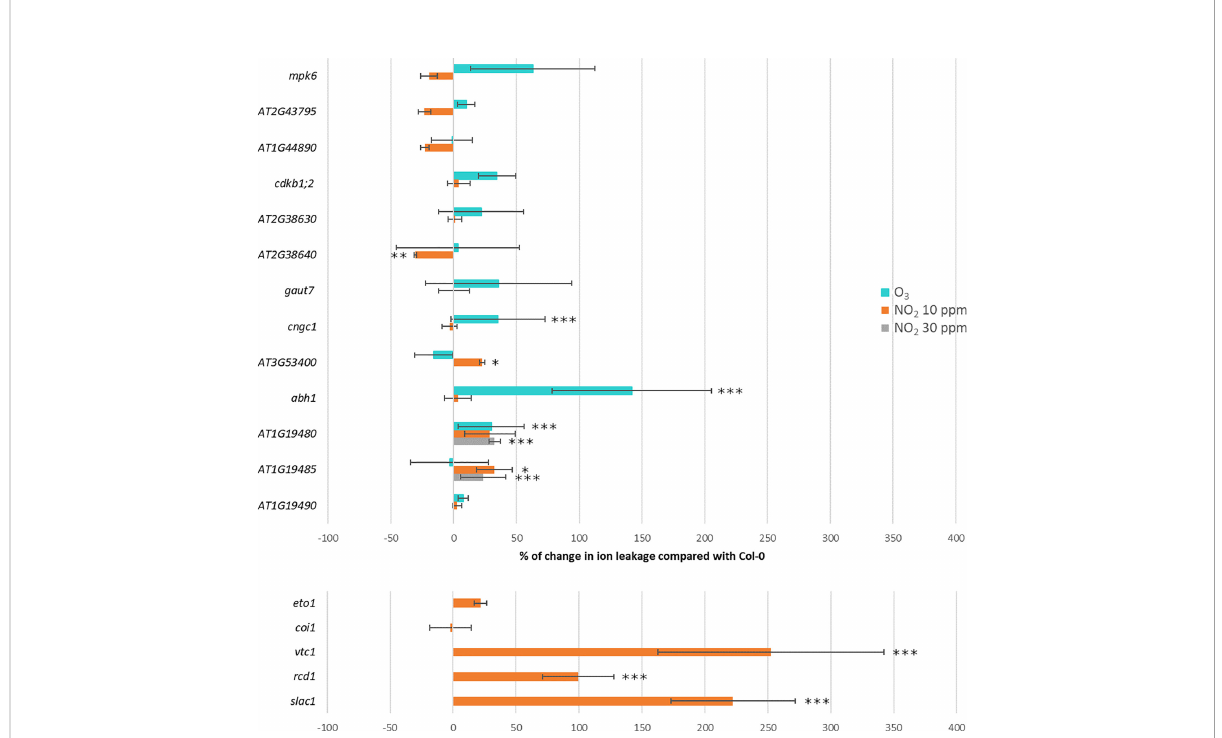
FIGURE 6 Percentage of change in ion leakage in GWAS candidate mutants (the upper part) and known O 3 sensitive mutants (the lower part of the fi gure) relative to Col-0. Treatment with 350 ppb of O 3 for 6h is marked in turquoise, 10 ppm of NO 2 for 6h in orange and 30 ppm of NO 2 for 1h in gray. Statistical signi fi cance is marked with asterisks: *** P < 0.001, ** P < 0.01 and * P <